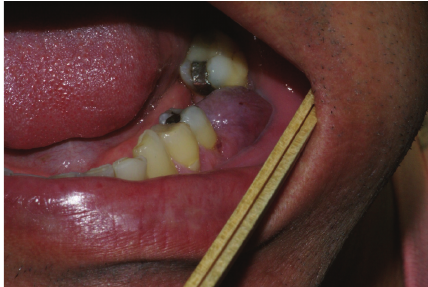
Figure 1: Clinical photograph of the painless purple pedunculated lesion associated with the dental implant.